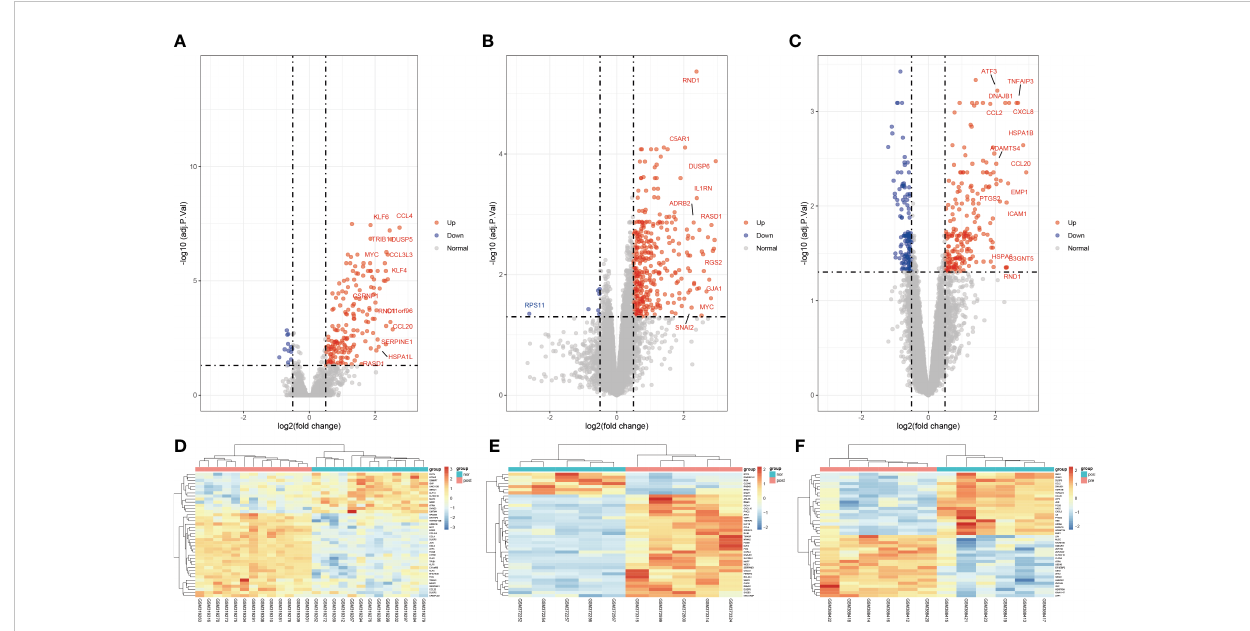
FIGURE 2 Volcano diagram and heat diagram. (A – C) Volcano map of GSE12720, GSE14951 and GSE15480. Upregulated genes are marked in light red; downregulated genes are marked in light blue. (D – F) Heat map of differentially expressed genes (DEGs) in GSE12720, GSE14951 and GSE15480. The top 40 DEGs for each dataset are shown on the heat